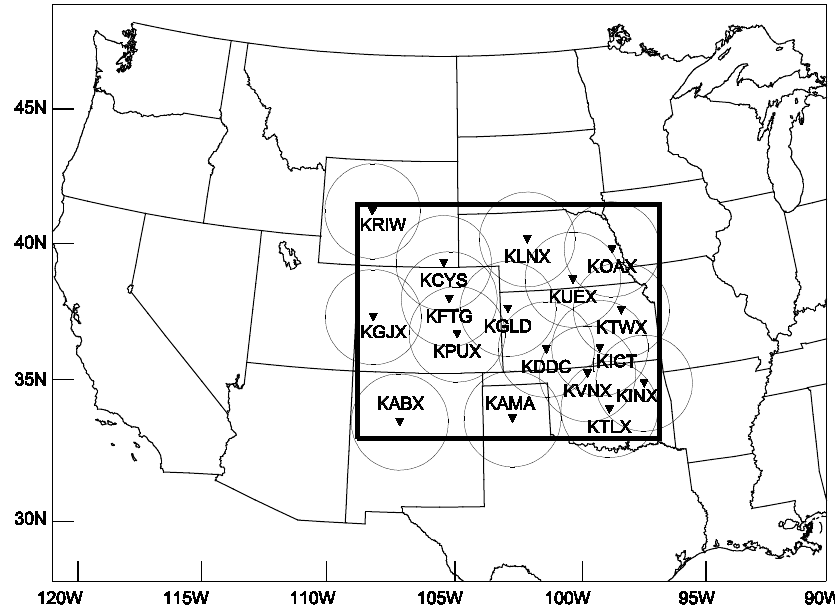
Figure 3. Outer and inner model domains and locations of 17 radar stations (inverted triangles).